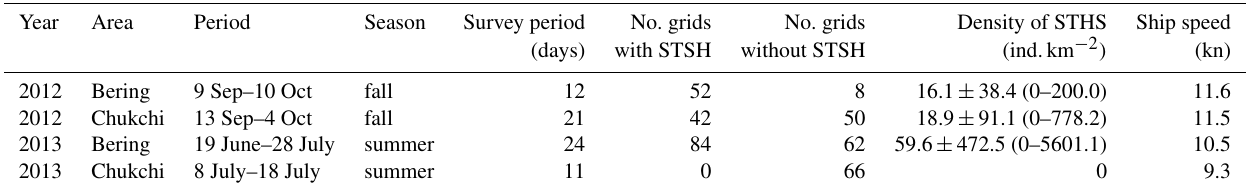
Table 1. Summary of vessel-based short-tailed shearwater ( Ardenna tenuirostris , STSH) surveys. The number of 50km 2 grids with and without STSH, as well as the density of STSH (birdskm − 2 in each 50km grid; mean ± SD; min.–max.) are